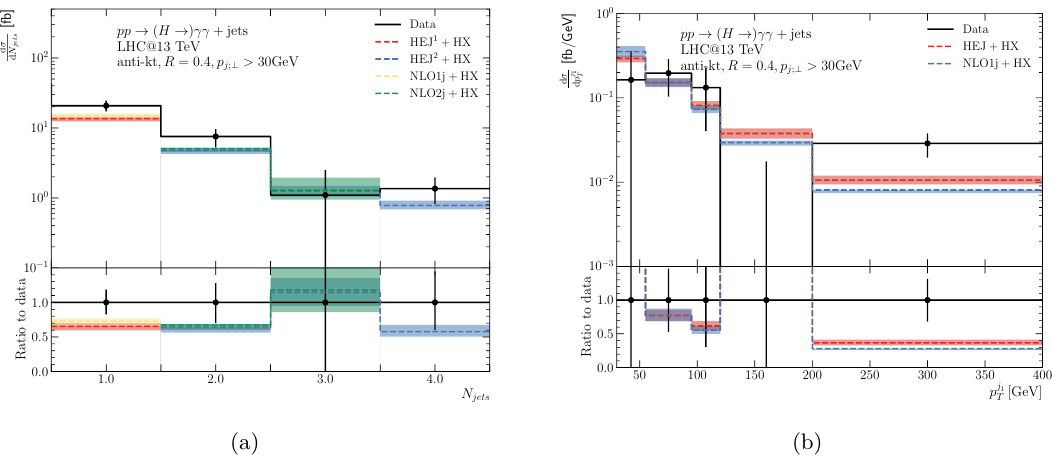
Figure 6. (a) The exclusive number of jets compared to CMS data from [32], and (b) the transverse momentum distribution of the leading jet compared to CMS data [31]. Both analyses employ the cuts described in table 2. The “HX” component is extracted from those